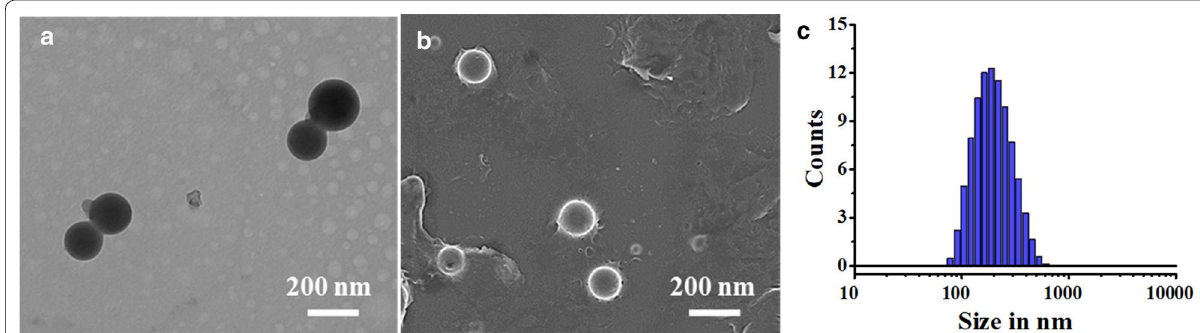
Fig. 2 a TEM analysis of Rh-PLGA-NPs@NH 4 , b SEM analysis of Rh-PLGA-NPs@NH 4 c Size distribution graph of Rh-PLGA-NPs@NH